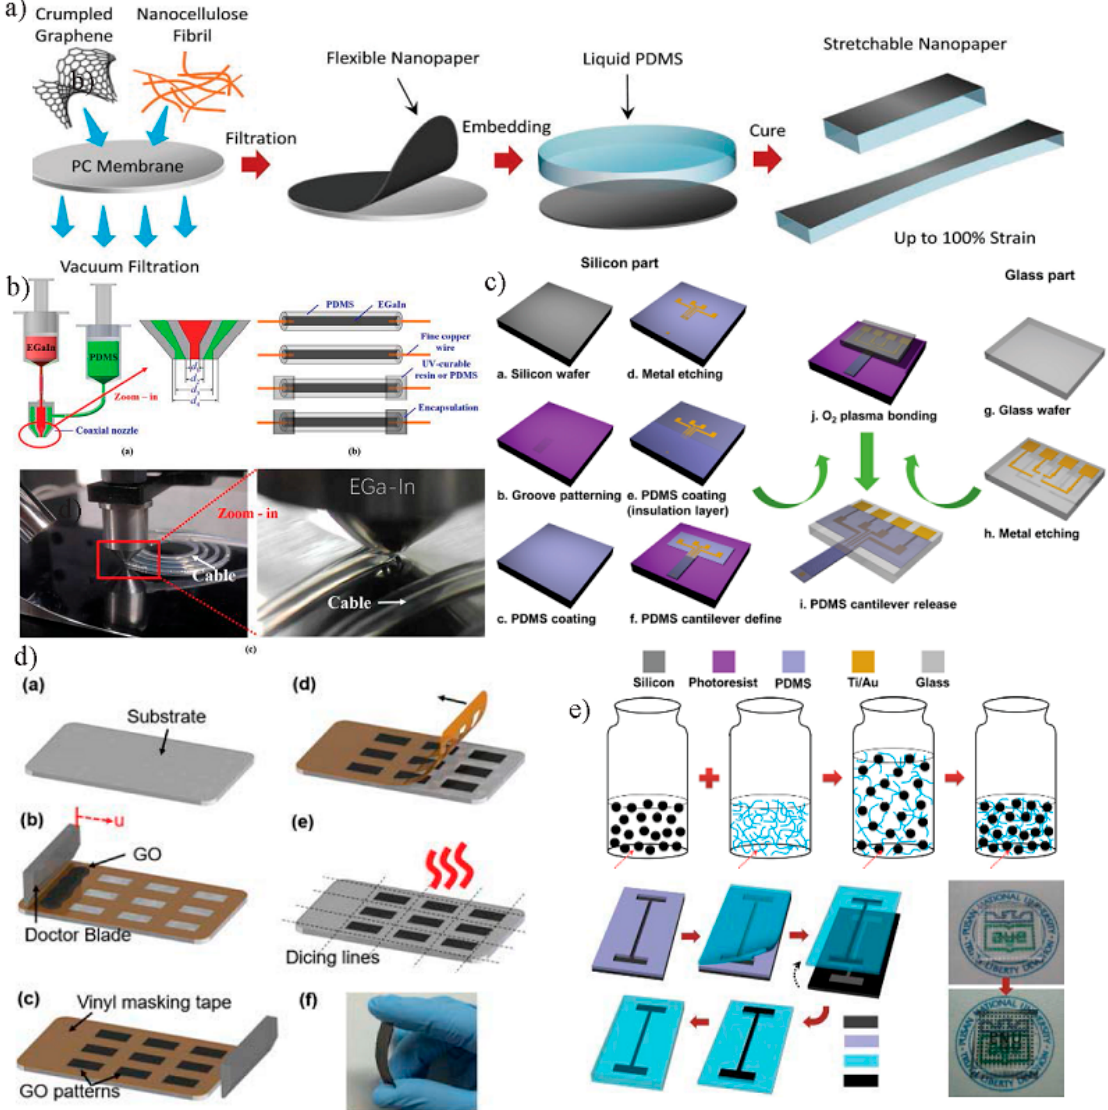
Figure 1. Fabrication methods of resistive-type strain sensors based on polydimethylsiloxane (PDMS) flexible substrates. ( a ) Schematic illustrations of the fabrication processes for stretchable graphene